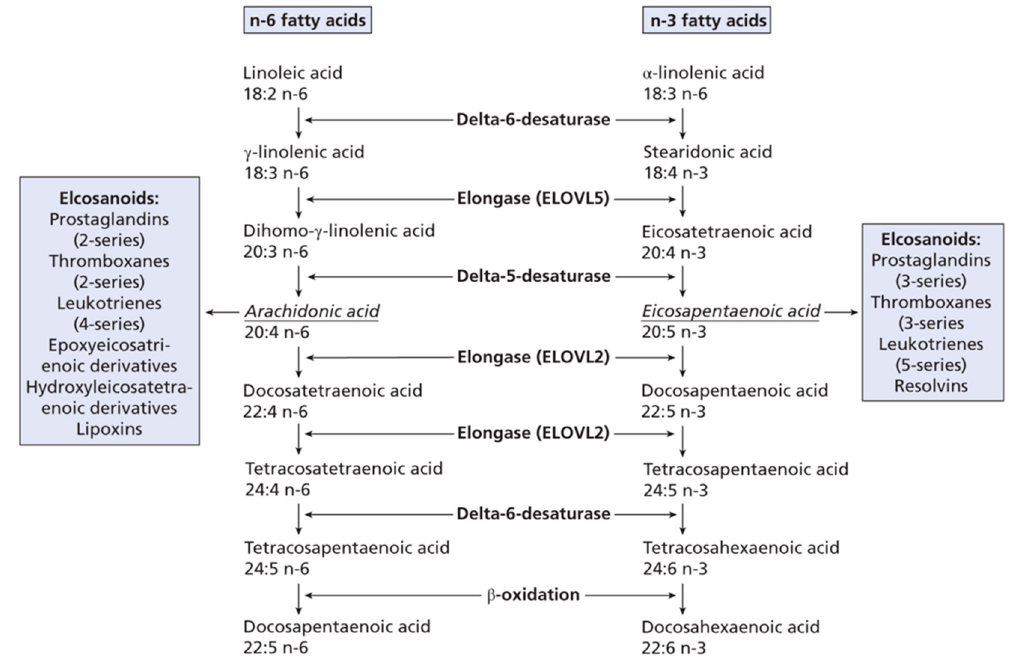
Figure 1. n-3 and n-6 fatty acid metabolism. Taken from [1], with permission. Lipids: Biochemistry,